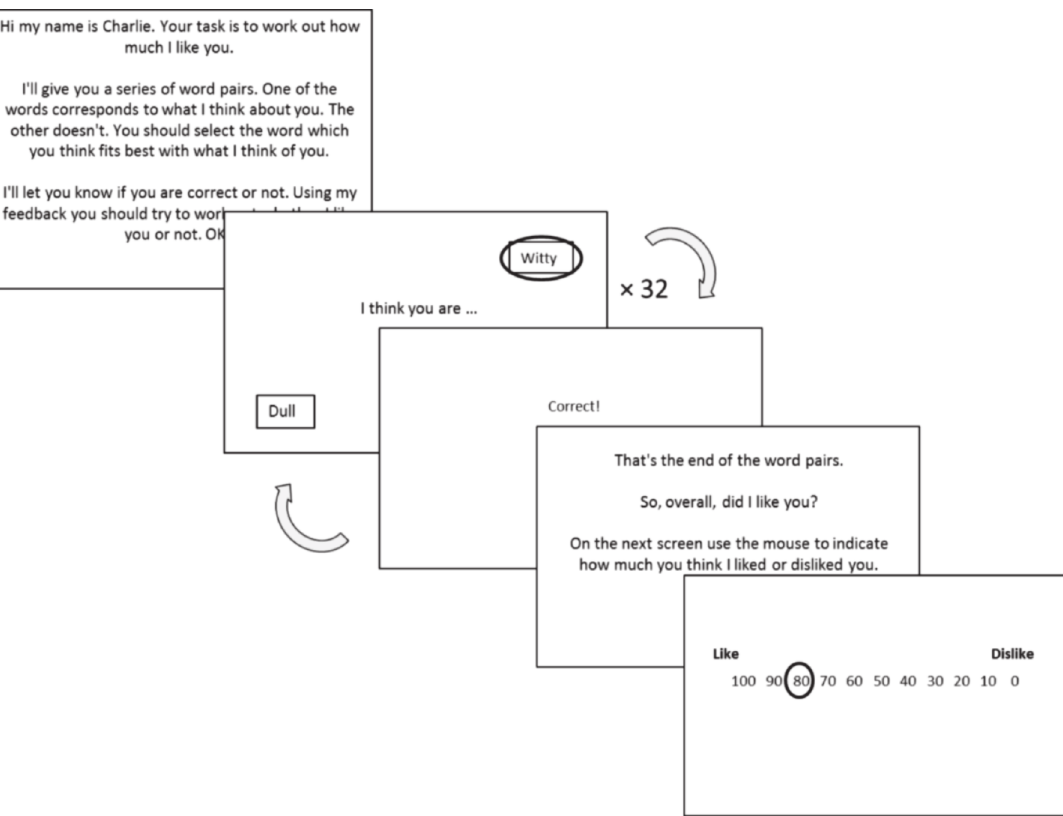
Fig 1. Example of a self-referential rule block in the social evaluation learning task. Each block contains a probabilistic learning phase where 32 word pairs and feedback are presented, and a global rating phase. There were 6 blocks in total, self-liked, self-neutral, self-disliked, other-liked, other-neutral, other-disliked. P[positive word correct] = 0.8, 0.5 and 0.2, for the liked, neutral and disliked rules respectively.